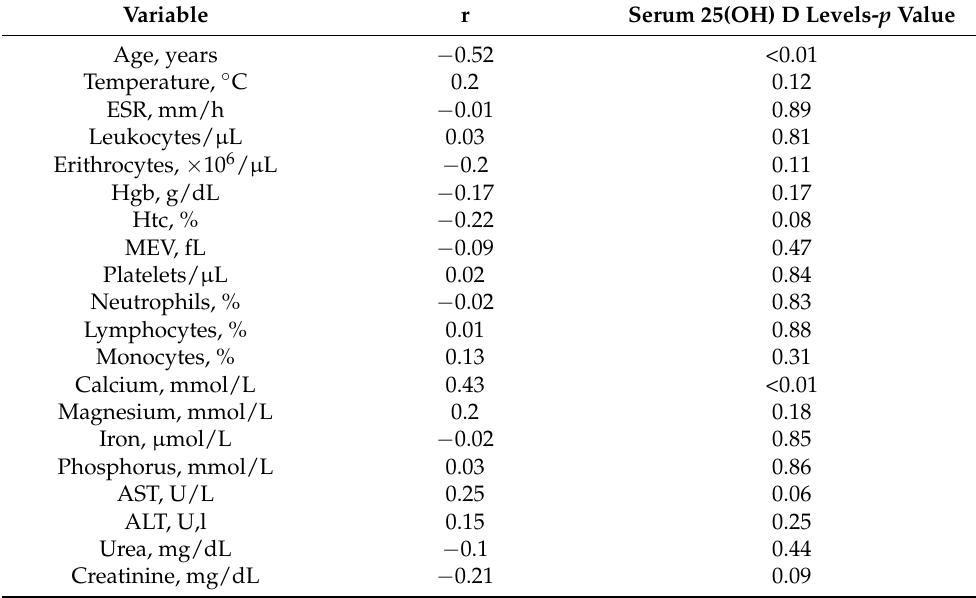
comparison of female/male ratio between the two study groups, divided within the three age groups revealed a positive, significant correlation of female sex and UTIs only for the age group of 1–2 years ( p = 0.03), as seen in Table 3. Table 2. Non-parametric Spearman correlations within the study group.